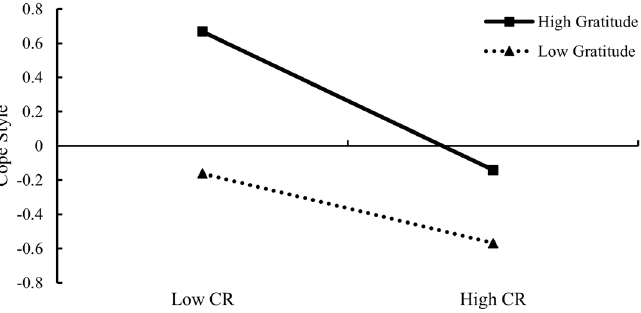
Figure 2. The interaction of CR and gratitude on cope style. Note: CR = cumulative risk. Table 3. Test for moderating mediating effects of CR on life satisfaction.